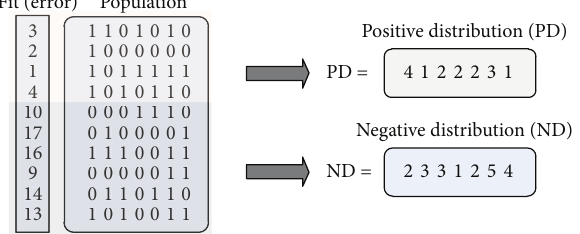
Table 5: Parameters in